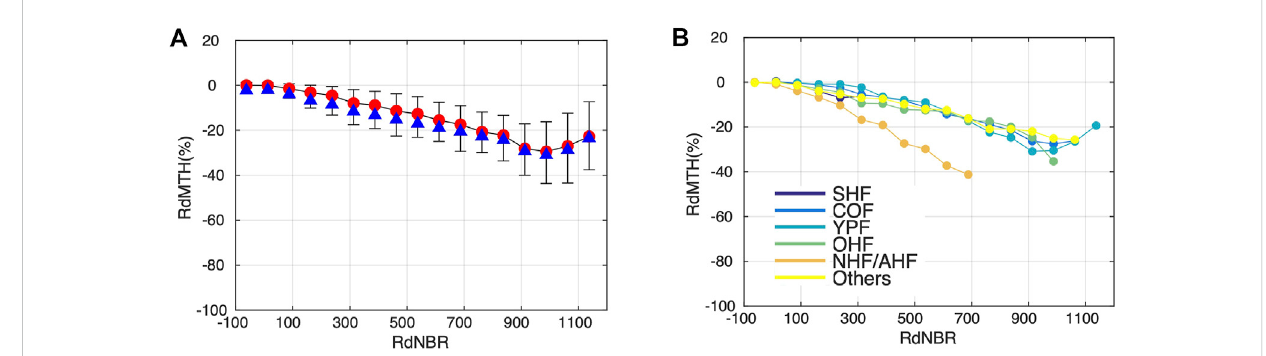
FIGURE 6 Comparison between burn severity measures (RdNBR and dMTH) from passive and active remote sensing sensors. Relations from all vegetation typesandeachtypeshownin (A) and (B) respectively.Inpanel (A) ,theredcircleandbluetrianglerepresentmedianandmeanvalues,anderrorbarsstand for the 25th and 75th percentile. In panel (B) , the colored circles represent median values of each vegetation type.